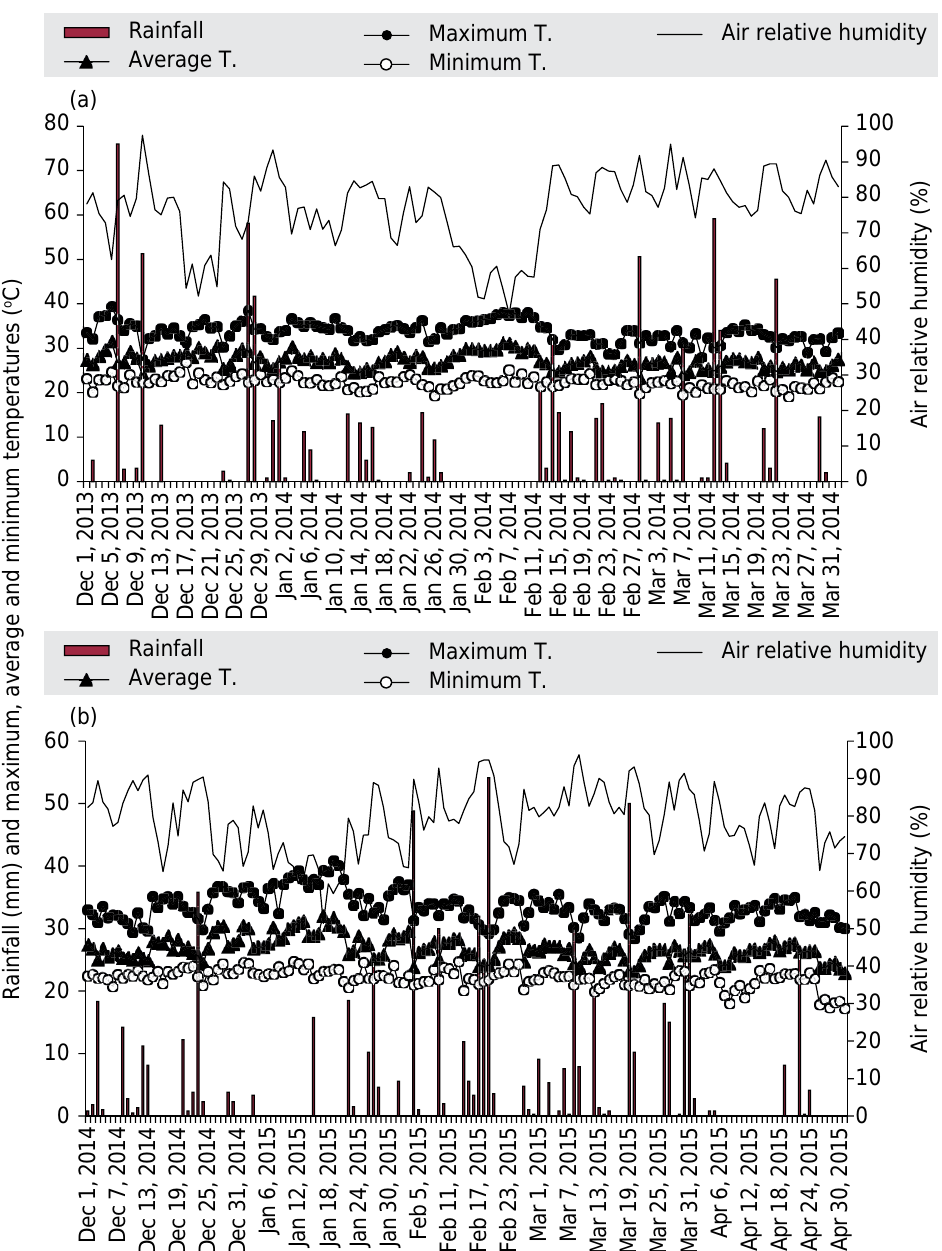
Figure 1. Rainfall, air relative humidity, and maximum, average, and minimum temperature obtained from the weather station located on the Education and Research Farm of FE / UNESP during corn cultivation in the period of December 2013 to April 2014 (a) and December 2014 to April 2015